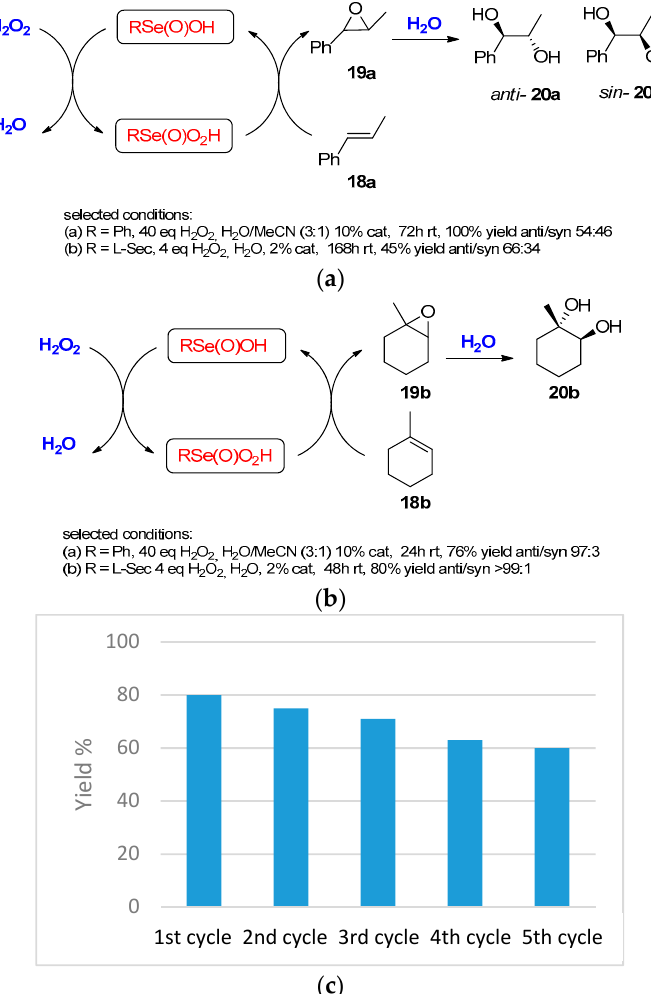
Figure 14. ( a ) and ( b ) Selenium catalyzed oxidation of 18a,b into 20a,b ; ( c ) Recyclability of the catalyst and the water in the oxidation of 18b into 20b .